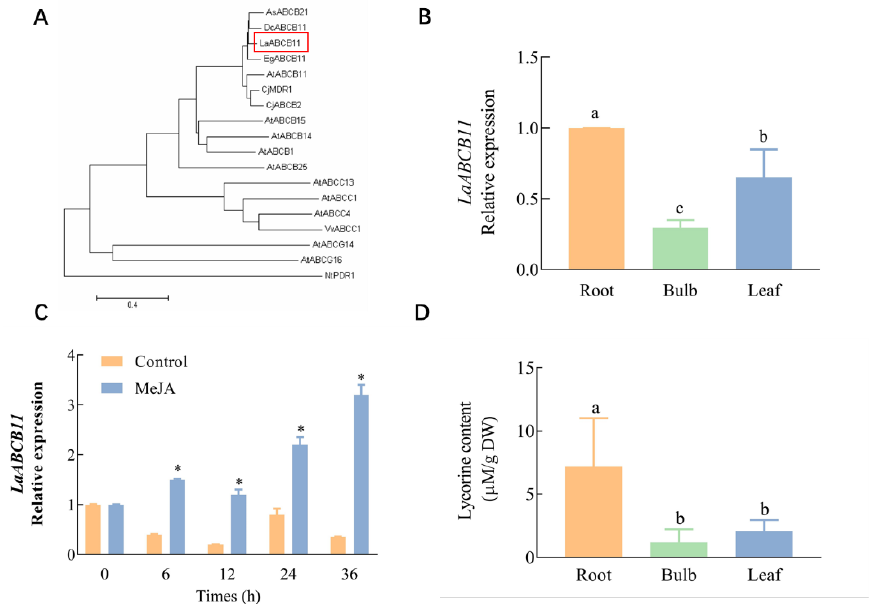
Figure 1. Characterization of LaABCB11 and lycorine content in different tissues of L. aurea . ( A ) Phylogenetic tree constructed using the MEGA 7.0 software. Sequences were found on the NCBI (https://www.ncbi.nlm.nih.gov/, 9/1/2021), LaABCB11 is boxed. ( B ) LaABCB11 expression level in different tissues of L. aurea ; and ( C ) under 100 µM MeJA treatment in leaves. ( D ) Lycorine content in different tissues of L. aruea seedling. The error bars represent standard deviations from three biological replicates, and different letters above the bars indicates significant difference determined by one-way ANOVA test ( p < 0.05), * indicates a significant difference determined by t -test ( p < 0.05), comparing with the control.